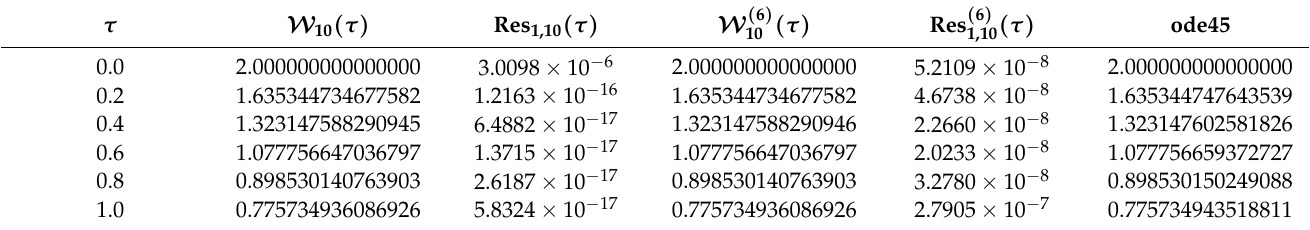
( τ ) in SMV/QLM-SMV procedure using Q = 10 W